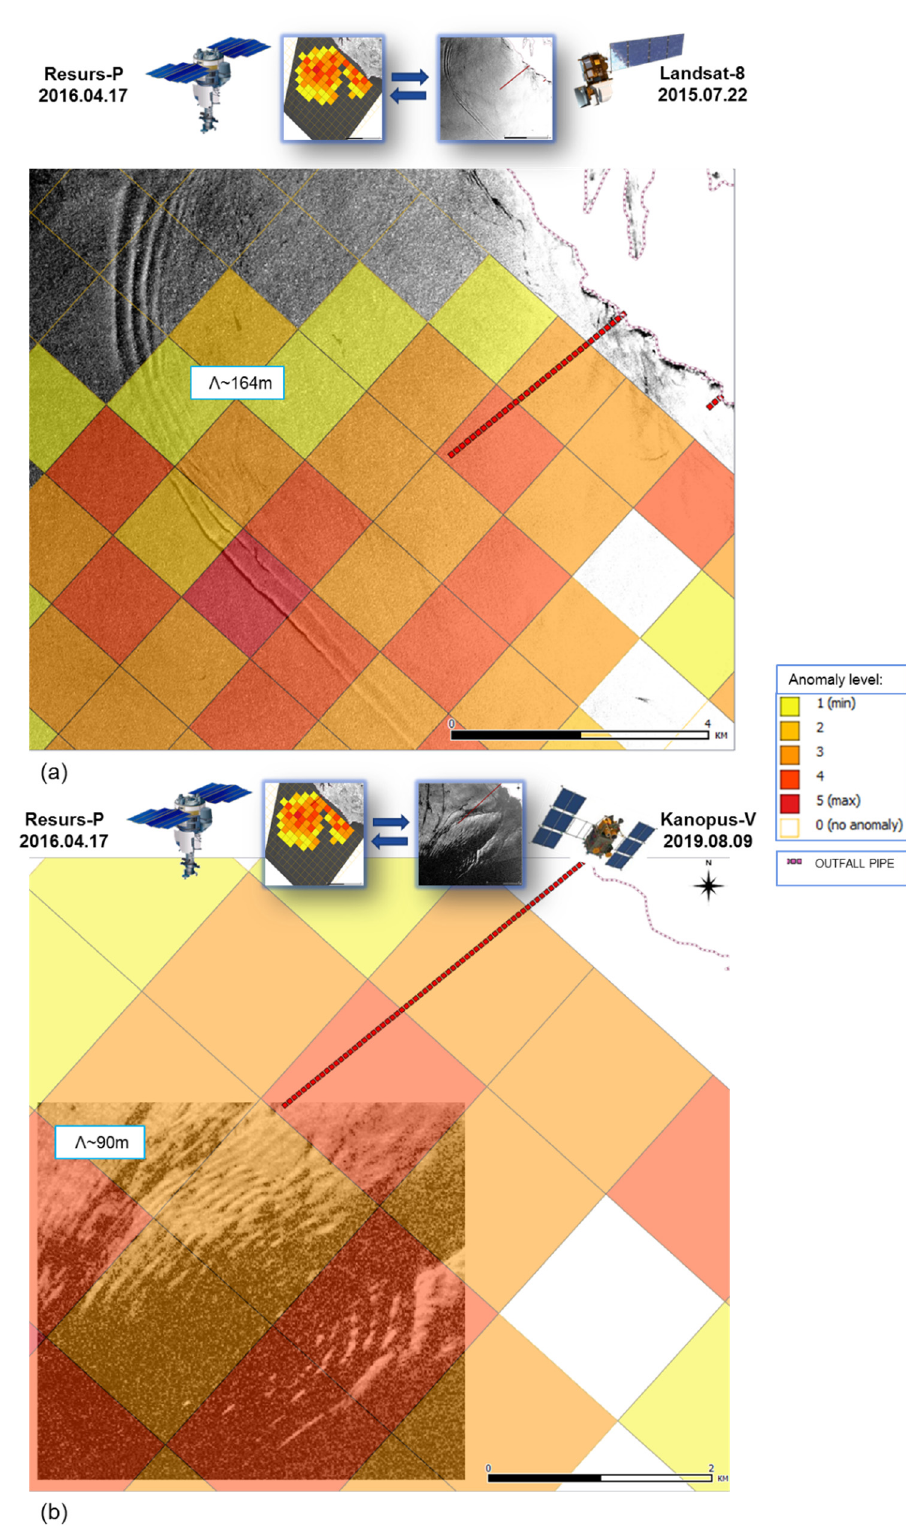
Figure 8. Example cases of visually detectable surface manifestations of internal waves (( a )–Landsat-8, ( b )–Kanopus-V) in the area of submerged discharge impact detected as a result of the analysis of spatial spectra of the Resurs-P image in Sevastopol coastal water areas.